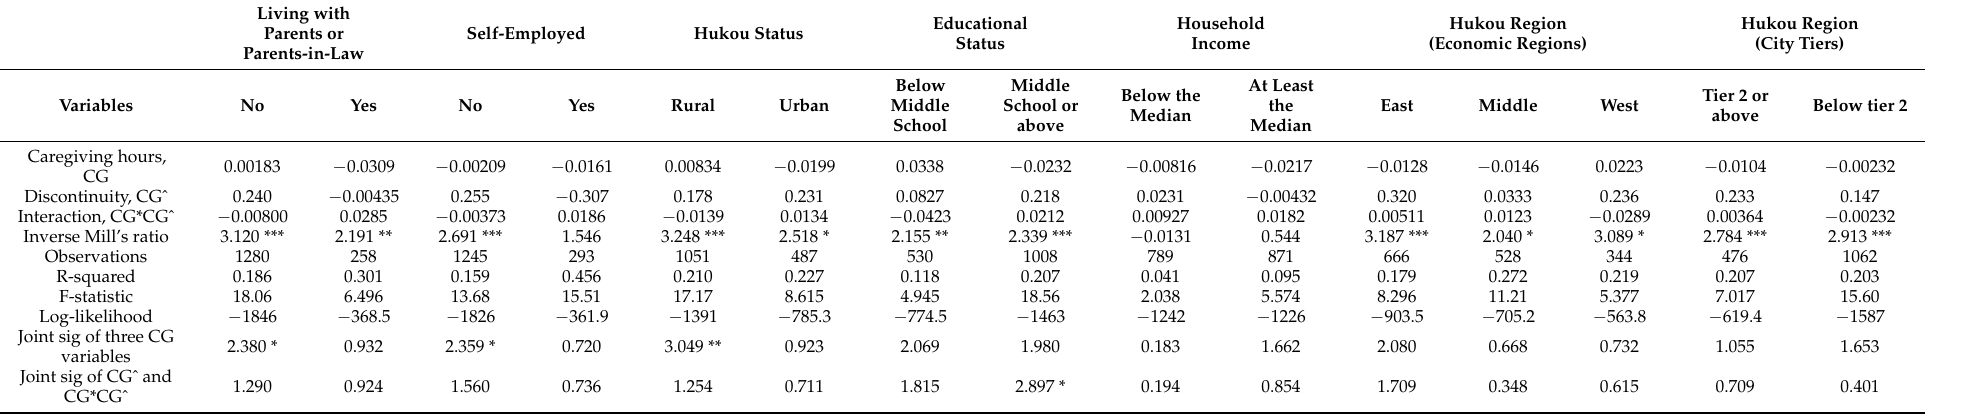
Table A6. Subgroup analysis on men using the Heckman procedure and assuming a weekly caregiving threshold of 15